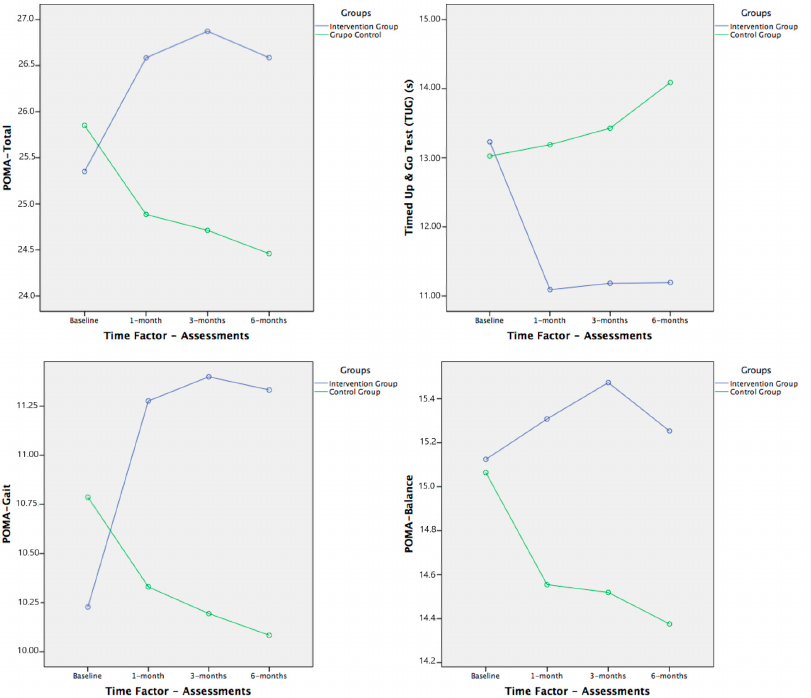
Figure 3. Within-group behavior and follow-up of performance-oriented mobility assessment (POMA) tests and timed up and go (TUG) test. Comparisons between both groups (significant models in multivariate ANOVA (MANOVA) analysis for POMA and TUG tests shown in Tables 2 and 3).